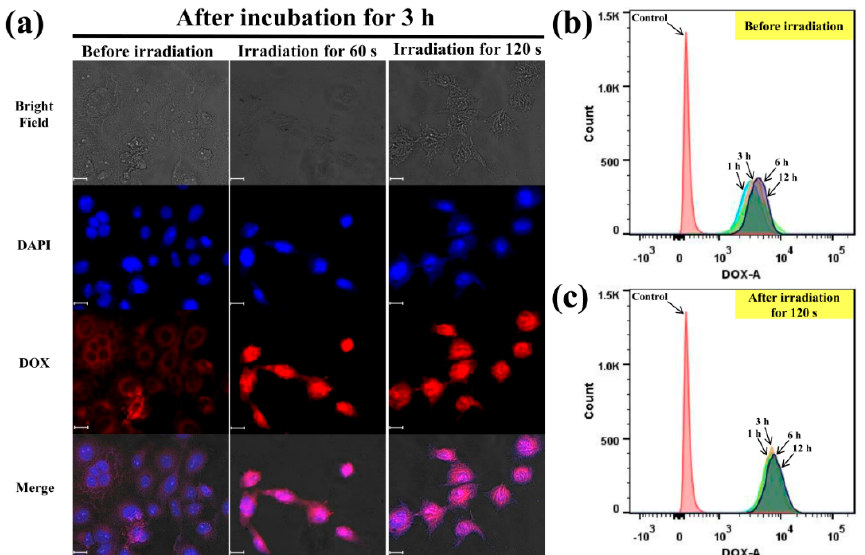
Figure 4. CLSM images of HeLa cells incubated with DOX/5-ALA-loaded A-PPG micelles at 3 h after irradiation. HeLa cells were stained with the nuclear marker DAPI (blue); conjugated DOX emits red fluorescence ( λ ex = 480 nm). All scale bars in ( a ) represent 20 µ m. Flow cytometric